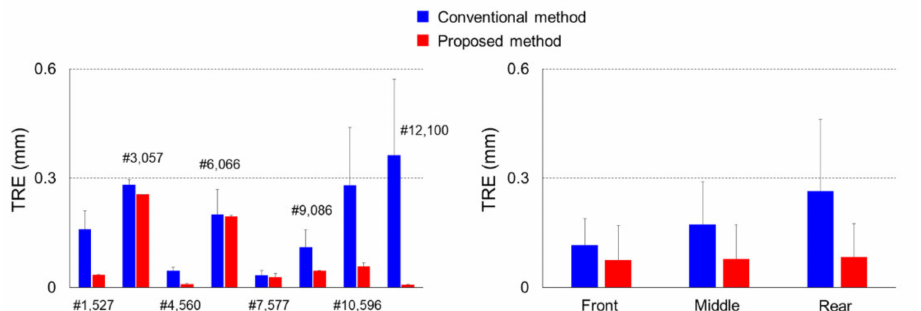
Figure 5. Comparison of target registration error (TRE) between the conventional and proposed registration strategies using the hemisphere